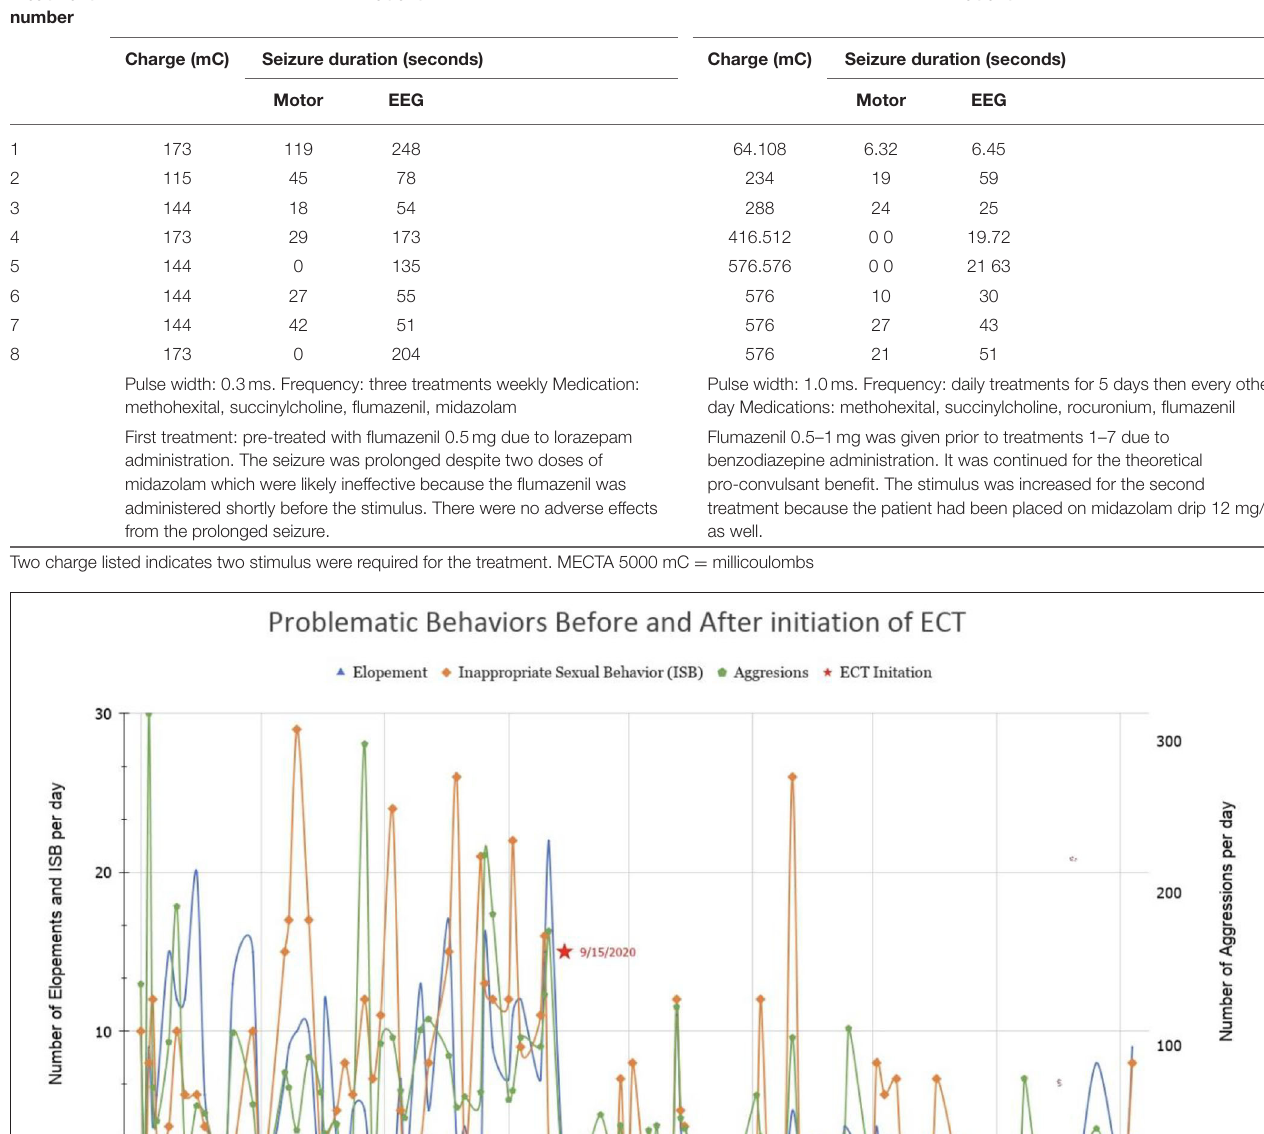
TABLE 2 | ECT treatment parameters and seizure duration for each patient. Electroconvulsive therapy treatment parameters and seizure duration Treatment number